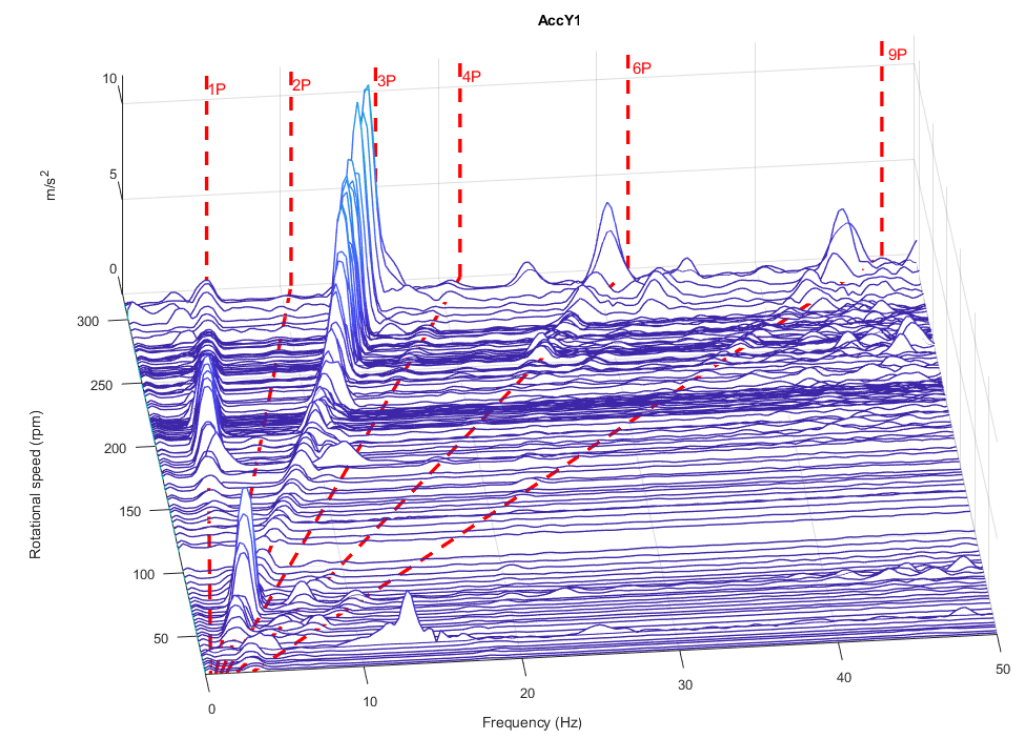
Figure 10. Waterplot of accelerations in y direction on layer